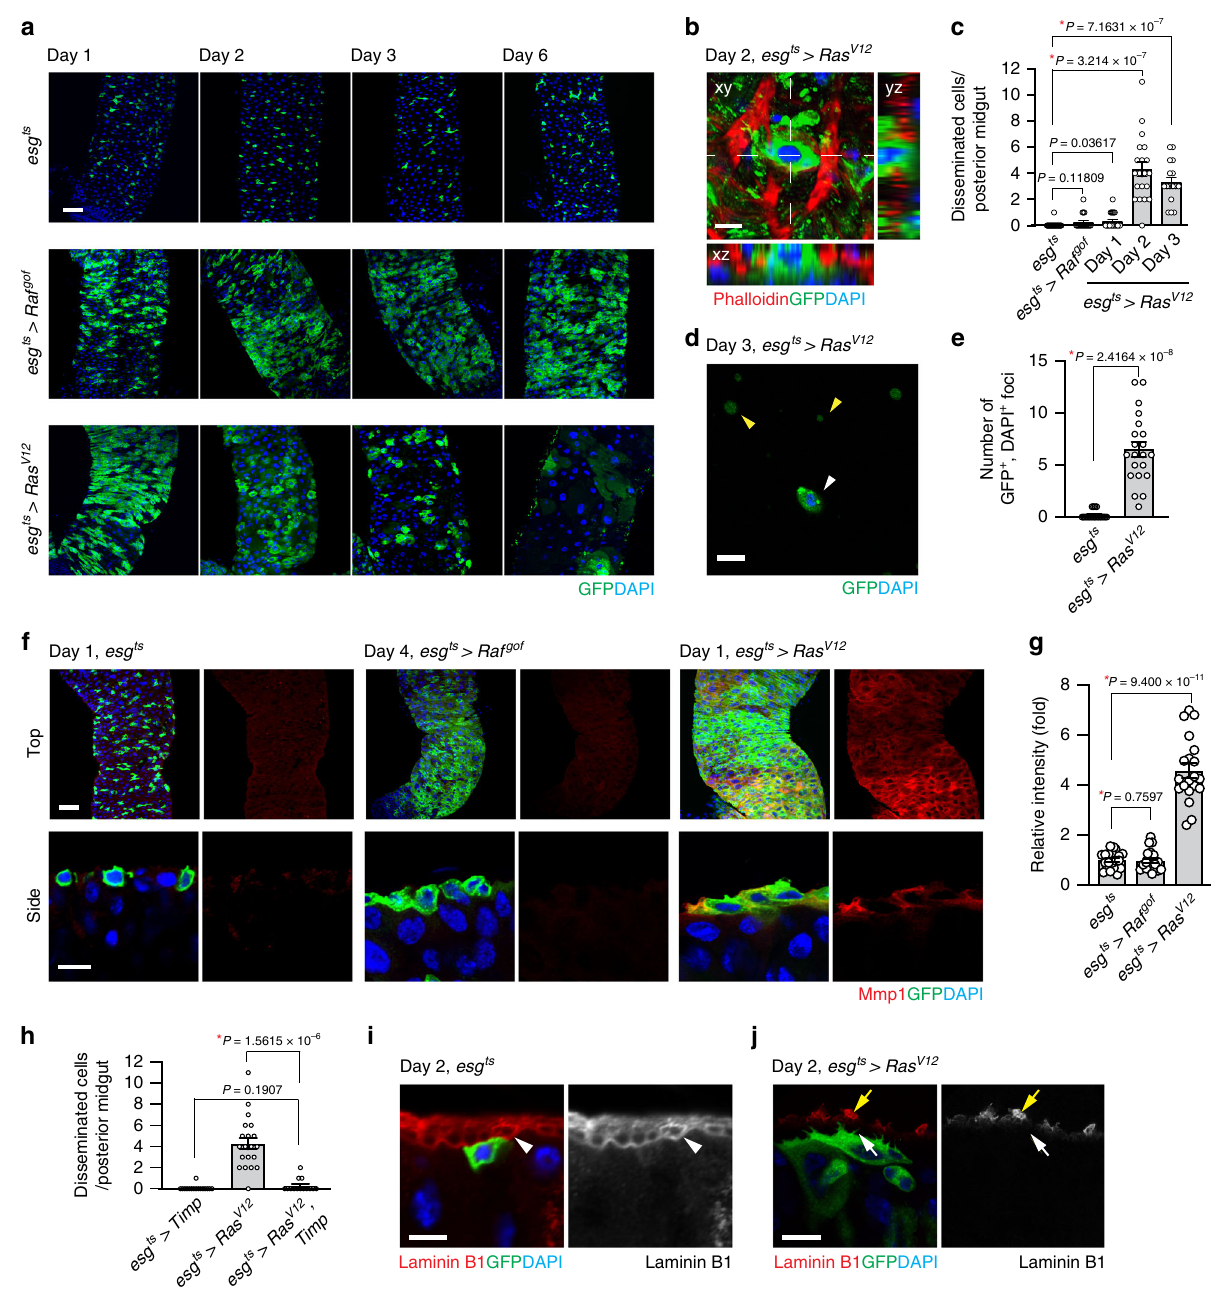
Fig. 1 Ras V12 cells basally disseminate from the posterior midgut. a Images of the posterior midgut. Transgenes were induced with esg ts by incubating at 29 °C for indicated durations. The cells manipulated by esg ts are marked and stained with GFP (green), and nuclei are stained with DAPI (blue). Scale bar, 50 µ m. b Representative image of disseminated cell. Top view (xy) and orthogonal views (yz and xz) are shown. Phalloidin (red) visualizes VM. Scale bar, 10 µ m. c Quanti fi cation of disseminated cells detected on the surface of posterior midgut. N = 25 ( esg ts ), N = 20 ( esg ts > Raf gof ), N = 21 (day 1, esg ts > Ras V12 ), N = 20 (day 2, esg ts > Ras V12 ), N = 16 (day 3, esg ts > Ras V12 ) biological replicates. d Representative image of GFP + and DAPI + cell (white arrowhead) detected in hemolymph. Ras V12 was expressed with esg ts for 3 days before hemolymph collection. GFP + and DAPI – particles (yellow arrowheads) were also detected. Scale bar, 10 µ m. e Quanti fi cation of circulating GFP + and DAPI + cells. N = 3 independent experiments for each genotype. f Mmp1 immunostaining (red) in posterior midguts. Lower panels show side view of the cells. Scale bars, 50 µ m (top) and 10 µ m (bottom). g Quanti fi cation of Mmp1 levels. N = 20 data points collected from seven biological replicates for each genotype. h Quanti fi cation of disseminated cells detected on the surface of posterior midgut. N = 16 ( esg ts > Timp ), N = 20 ( esg ts > Ras V12 ), N = 14 ( esg ts > Ras V12 , Timp ) biological replicates. I – j Laminin B1 staining of midguts. esg ts and esg ts > Ras V12 midguts were stained with anti-laminin B1 antibody. White arrowhead in the esg ts image points to the inner laminin layer adjacent to the epithelium, white arrow in the esg ts > Ras V12 images points the boundary of the epithelium where laminin is degraded, and yellow arrow in the esg ts > Ras V12 images points to a patchy laminin signal outside VM. Scale bar, 10 µ m. In the side views, the basal side of epithelia is positioned upward. In ( c ), ( e ), ( g ), and ( h ), mean ± SEMs are shown with individual data points. Data were analyzed by two-tailed unpaired Student ’ s t -test. Asterisks indicate statistical signi fi cance (* P < 0.01) and P values are indicated in